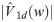
Validation of FIE along the real axis w, by substituting η = −k cos w.Left: absolute value of |V^1d(w)| (exact = thick solid gray line, approximate = solid black line). Right: relative error in log10 scale obtained from the approximate expression of V1d(η) for η = −k cos w given by while substituting the exact expression of V1+(η) and performing the numerical integration. Test cases are relative to different sets of parameters: Φa,=0.7π,0.4π,0.18¯π, Φb = 1.2π, φo = 0.1π. We recall that −π < w < 0 is the portion of real axis of w plane in the proper sheet of η plane.